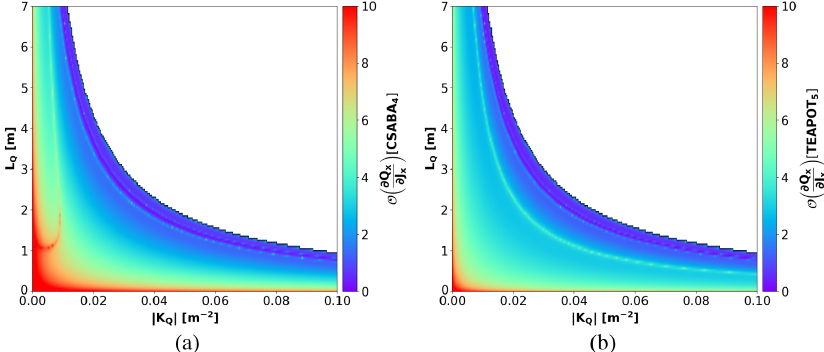
∂ Q j Þ for differed lattice configurations using (a) the CSABA 4 and (b) the TEAPOT 5 symplectic ∂ J j